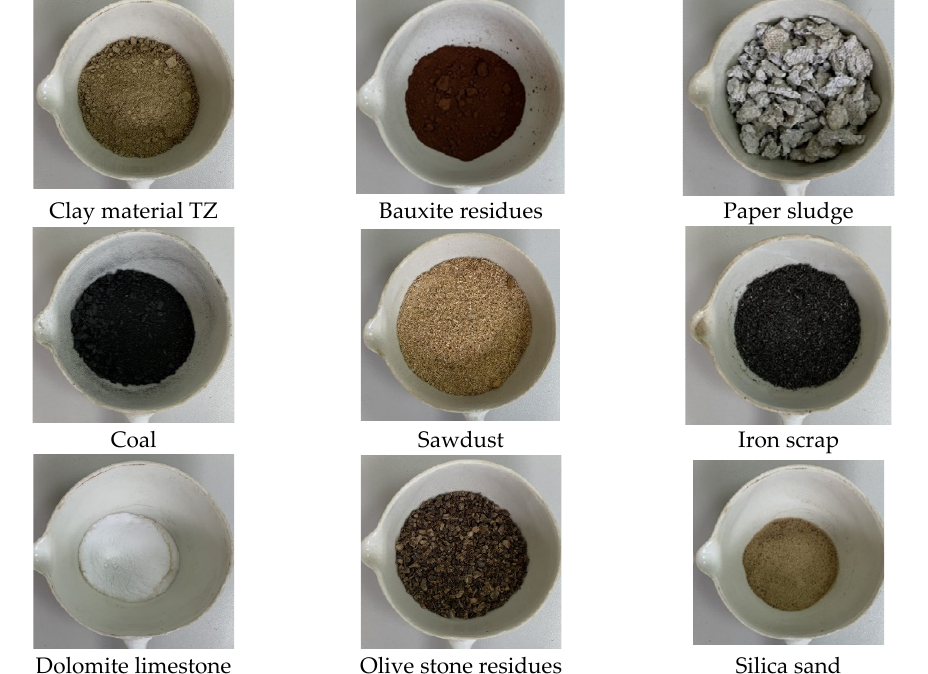
Figure 1. Clay material and solid waste additives used for the study.